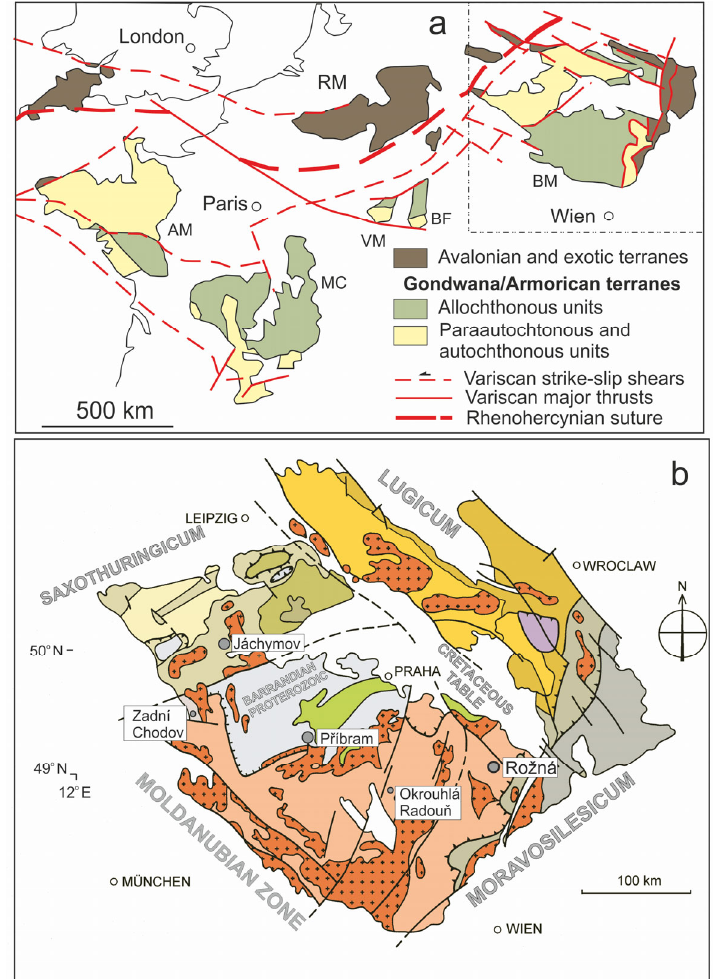
Figure 1. ( a ): A sketch of the Variscan belt of Central and Western Europe (following [19]); ( b ): sim ‐ plified geological map of the Bohemian Massif and location of the uranium deposits discussed in the text. Abbreviations in ( a ): BM: Bohemian Massif; MC: Massif Central; AM: Armorican Massif; BF: Black Forest; VM: Vosges Massif; RM: Rhenish Massif. Abbreviations in ( b ): MZ: Moldanubian zone (allochthonous unit); Gr: Pre ‐ Variscan and Variscan granitoids; TBU: Teplá–Barrandian Zone (Neoproterozoic and Lower Paleozoic sediments and volcanites); SAXTHUR: Saxothuringian Zone (para ‐ autochthonous and autochthonous units);WS: West Sudetes (paraautochthonous and alloch ‐ thonous units);LU: Lugian Zone (exotic terrane and autochthonous units); MSZ: Moravian–Silesian Zone (exotic or Avalonian units); CB: Culm basin; PC: Platform cover (Cretaceous and Tertiary sed ‐ iments).